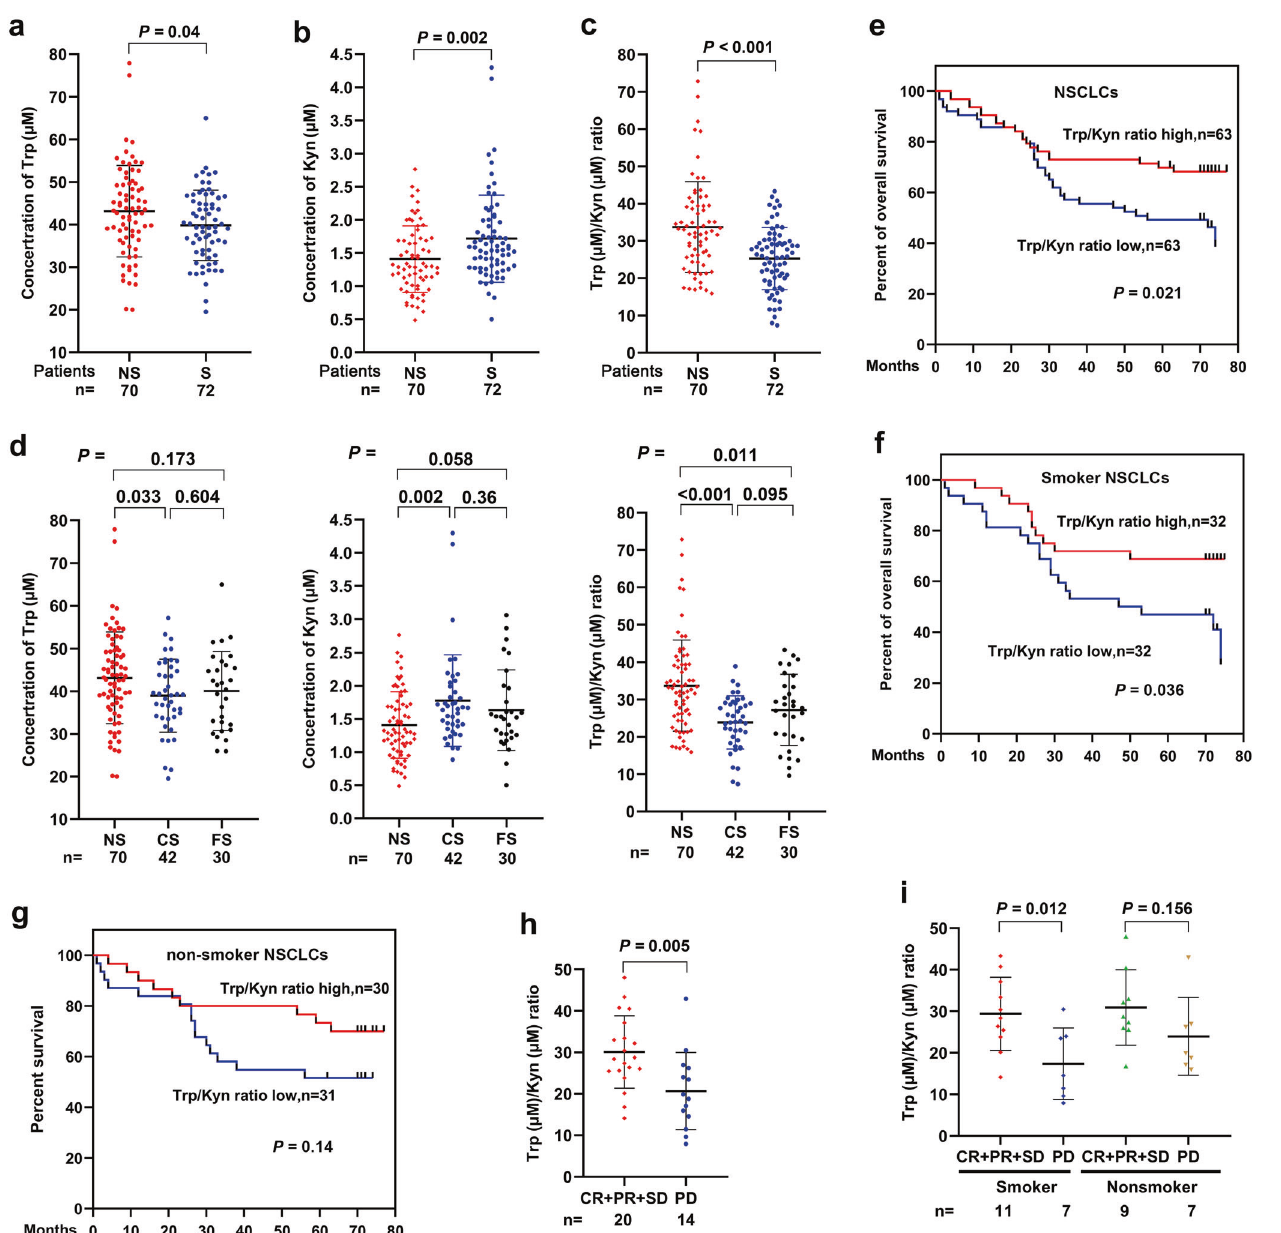
Fig. 1 Trp metabolism is more active in smoker than in nonsmoker patients with NSCLC and is associated with poor prognosis. a – c Plasma tryptophan (Trp) concentration ( a ), kynurenine (Kyn) concentration ( b ) and Trp/Kyn ratio ( c ) in NSCLC patients. d Plasma concentration of Trp and Kyn and the Trp/Kyn ratio in current smoker (CS), former smoker (FS), and nonsmoker (NS) patients with NSCLC. e – g Overall survival of all patients ( e ), smoker patients ( f ) and nonsmoker patients with NSCLC ( g ). h The relationship between the response rate and plasma Trp/Kyn ratio in NSCLC patients treated with an anti-PD1 antibody. i The relationship between the response rate and the plasma Trp/Kyn ratio in smoker and nonsmoker NSCLC patients treated with an anti-PD1 antibody. P values, Student ’ s t test. Error bars, prognosis of patients at an early (Supplementary Fig. 1e) or late stage (Supplementary Fig. 1f), possibly due to the small sample size of each group. (Fig. 1i). We also analyzed the potential effects of the age (Supplemen- tary Fig. 1a), gender (Supplementary Fig. 1b), smoking (Supple- mentary Fig. 1c) and stage (Supplementary Fig. 1d) on the prognosis of the patients, and found that only Stage had a signi fi cant effect on the outcome, in that patients at an early stage (Stage I and II, n = 49) had a much more favorable prognosis than patients at a late stage (Stage III and IV, n = 58; Supplementary Fig. 1d). However, Trp/Kyn ratio did not show a signi fi cant effect on